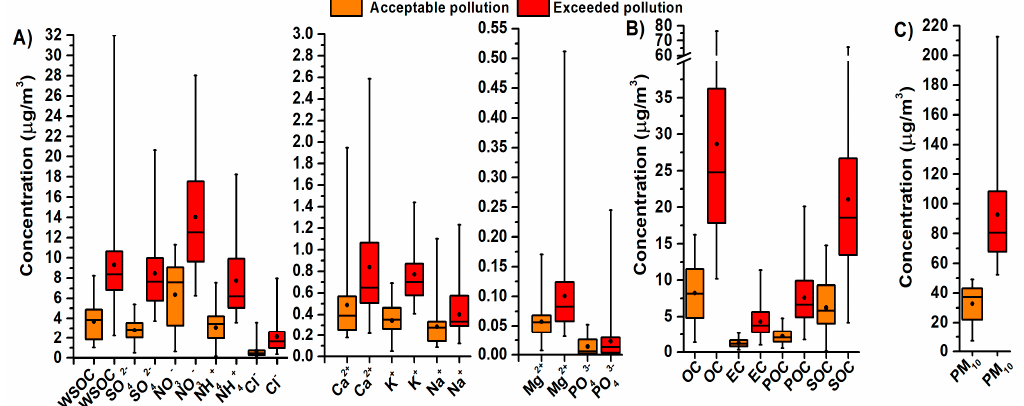
Figure 2. Boxplot in the period of acceptable and exceeded pollution for concentrations of water-soluble ions in PM 10 ( A ); concentrations of carbon forms in PM 10 ( B ) and for concentrations of PM 10 ( C ). Explanations: Water soluble organic carbon (WSOC), secondary organic carbon (SOC), particulate organic carbon